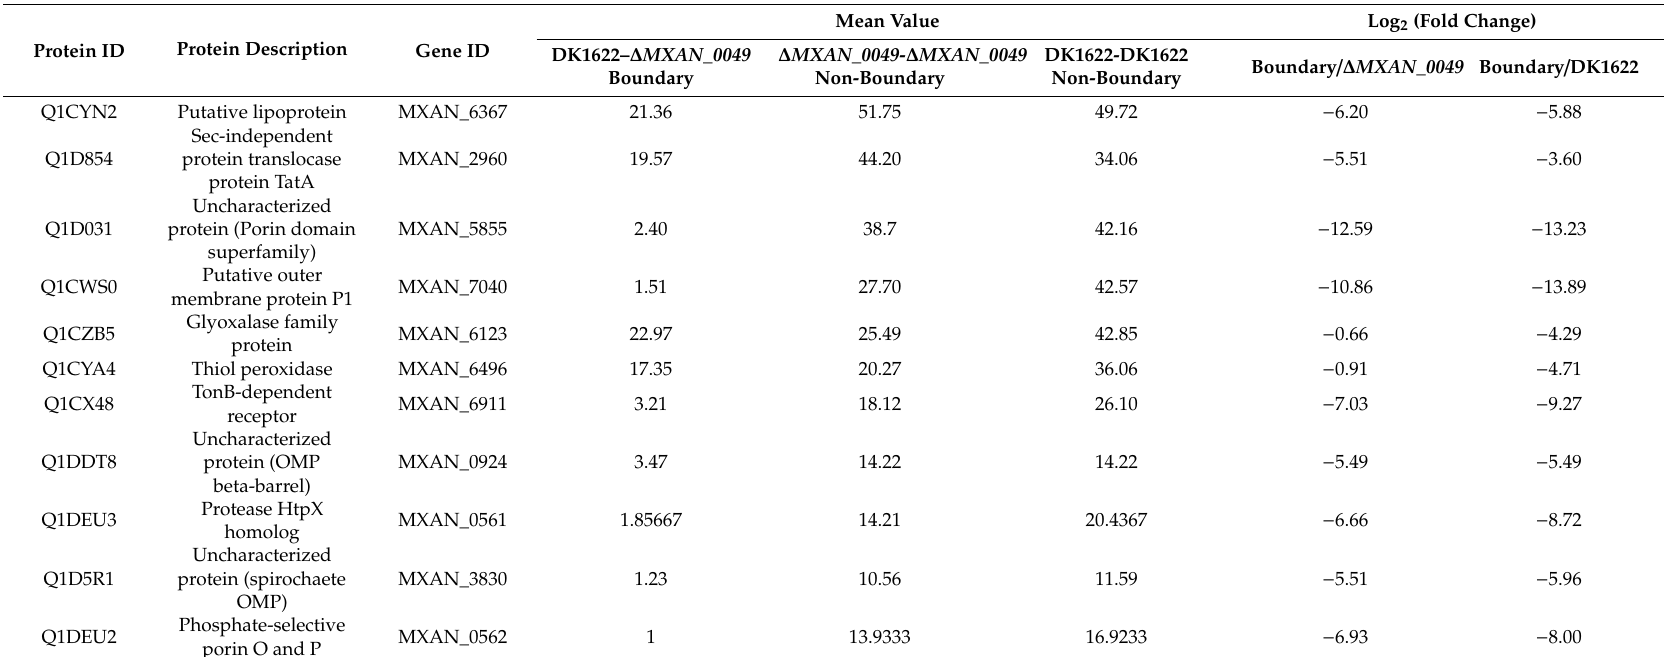
Table 2. List of down regulated proteins in